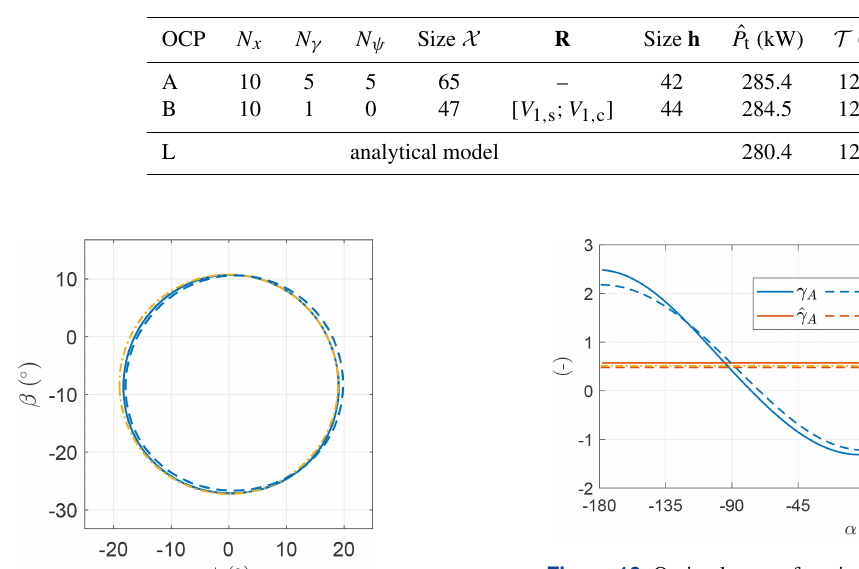
Figure 10. Optimal γ as a function of the angular